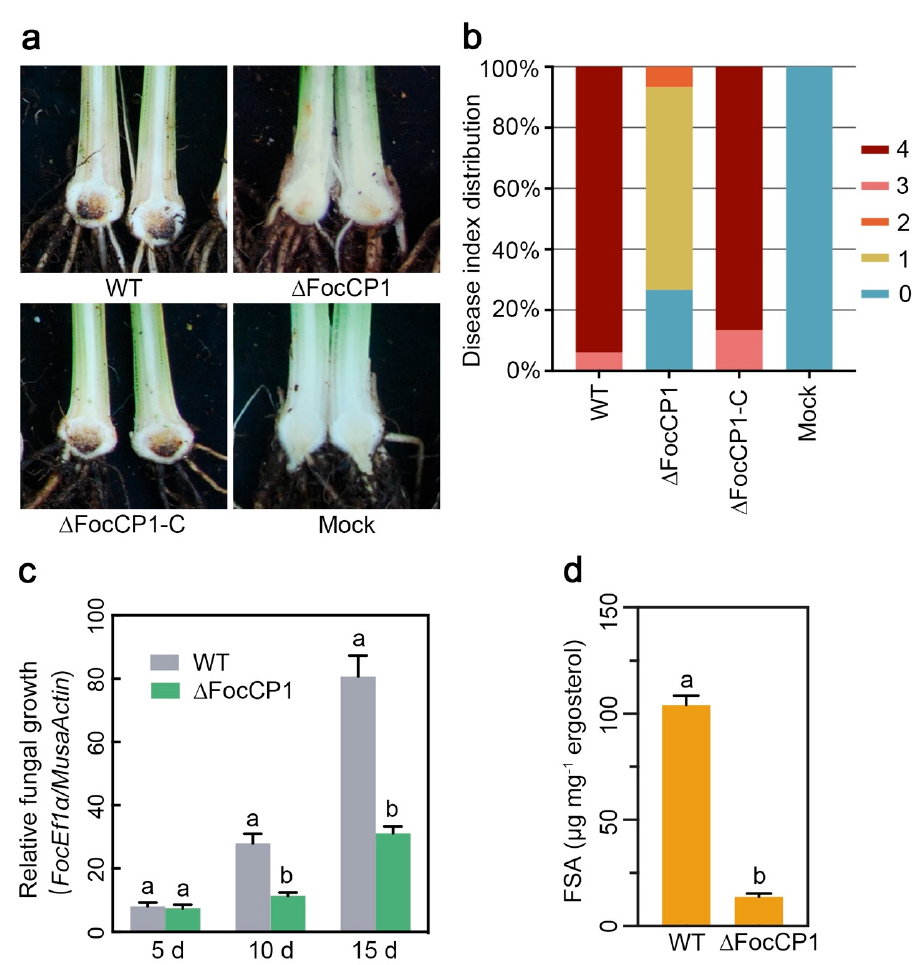
Figure 6. The deletion mutant ∆ FocCP1 is attenuated in virulence in banana plantlets. ( a ) Disease phenotype and ( b ) disease index distribution in inoculated banana plantlets caused by the WT, ∆ FocCP1, and ∆ FocCP1-C-GFP strains at 5 weeks post-inoculation. ( c ) In planta fungal growth in banana roots of the inoculated plantlets. Relative fungal growth was evaluated by qRT-PCR analysis of the FocEF1 α and banana actin genes and shown as ratios of FocEF1 α /MusaActin . Data are the means ± SDs from three independent experiments and different the letters above the columns indicate a significant difference at the p < 0.01 level between the WT and ∆ FocCP1 strains at the same time point. ( d ) The amount of fusaric acid (FSA) (mg − 1 of fungal ergosterol) produced by the WT, ∆ FocCP1, and ∆ FocCP1-C-GFP strains in infected banana roots was determined after 10 days of inoculation. Data